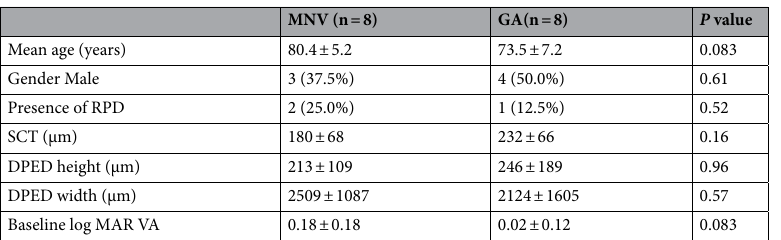
Table 3. Comparison of baseline characteristics between patients developing macular neovascularization (MNV) and geographic atrophy (GA). RPD: reticular pseudodrusen, SCT: subfoveal choroidal thickness, log MAR: logarithm minimum angle of resolution, BCVA: best-corrected visual